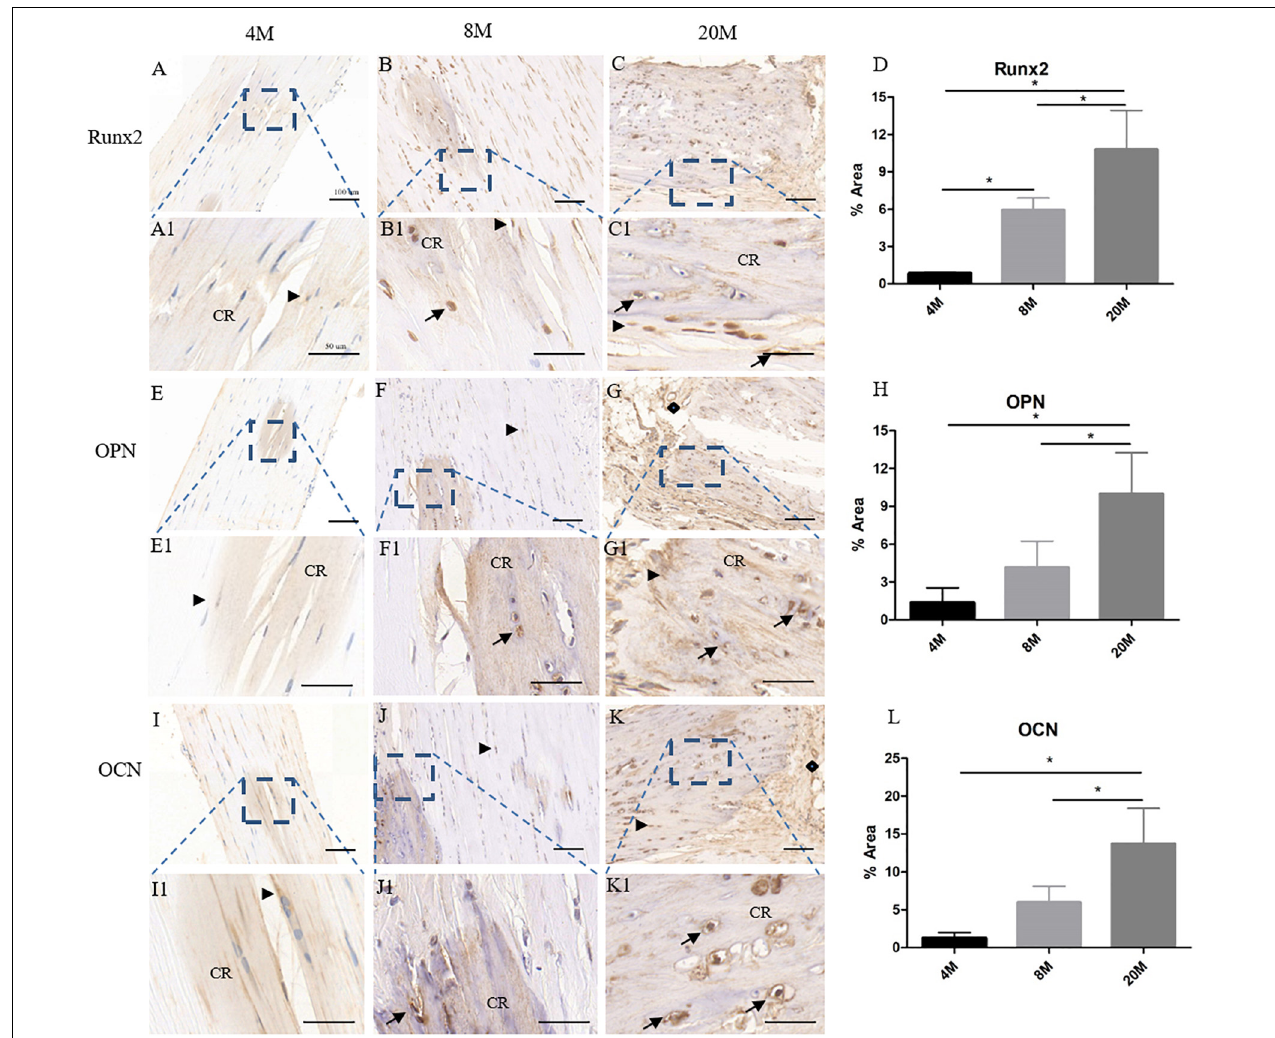
FIGURE 3 | The osteogenesis-related genes expression in ossified tendon was increased with aging. Immunohistochemistry (IHC) staining of osteogenesis-related gene markers in ossified tendon aged 4, 8, and 20 M. IHC staining results revealed higher expression level of Runx2 (A–C,A1–C1) , OPN (E–G,E1–G1) , and OCN (I–K,I1–K1) in aged tendon. An increased trend with age of Runx2 (D) , OPN (H) , and OCN (L) expression was observed in ossified tendon by semi-quantitative IHC assays. Arrowhead: rounded tendon cells; arrow: chondrocyte-like cells; CR, calcified region; rhombus: blood vessels. Scale bar = 100 µ m (A–C,E–G,I–K) ; Scale bar = 50 µ m (A1–C1,E1–G1,I1–K1) . ∗ P <